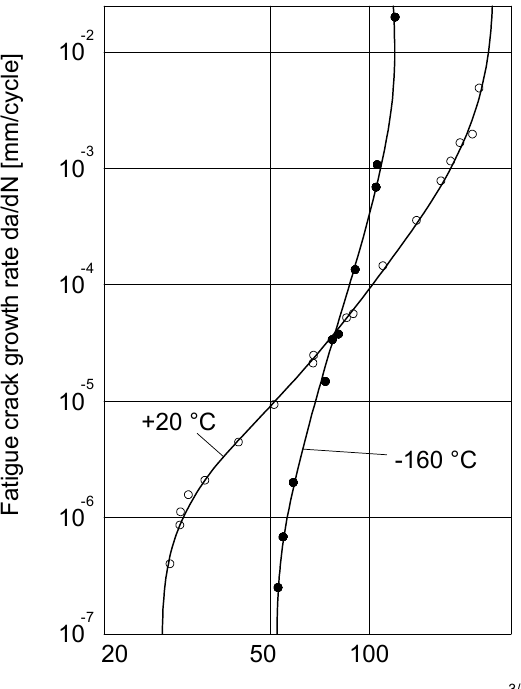
Figure 14. A fatigue crack growth rate (da/dN) versus stress intensity factor range ( ∆ K ) curve for a low-carbon steel above and below the FTT, based on Yarema et al. [56] and taken from Braun [32]. With testing of multiple temperatures at only one value of ∆ K , it is impossible to know if the ∆ K value is below, at, or above the intersection. Hypothetically, materials that were tested at the intersection should show little influence of temperature.